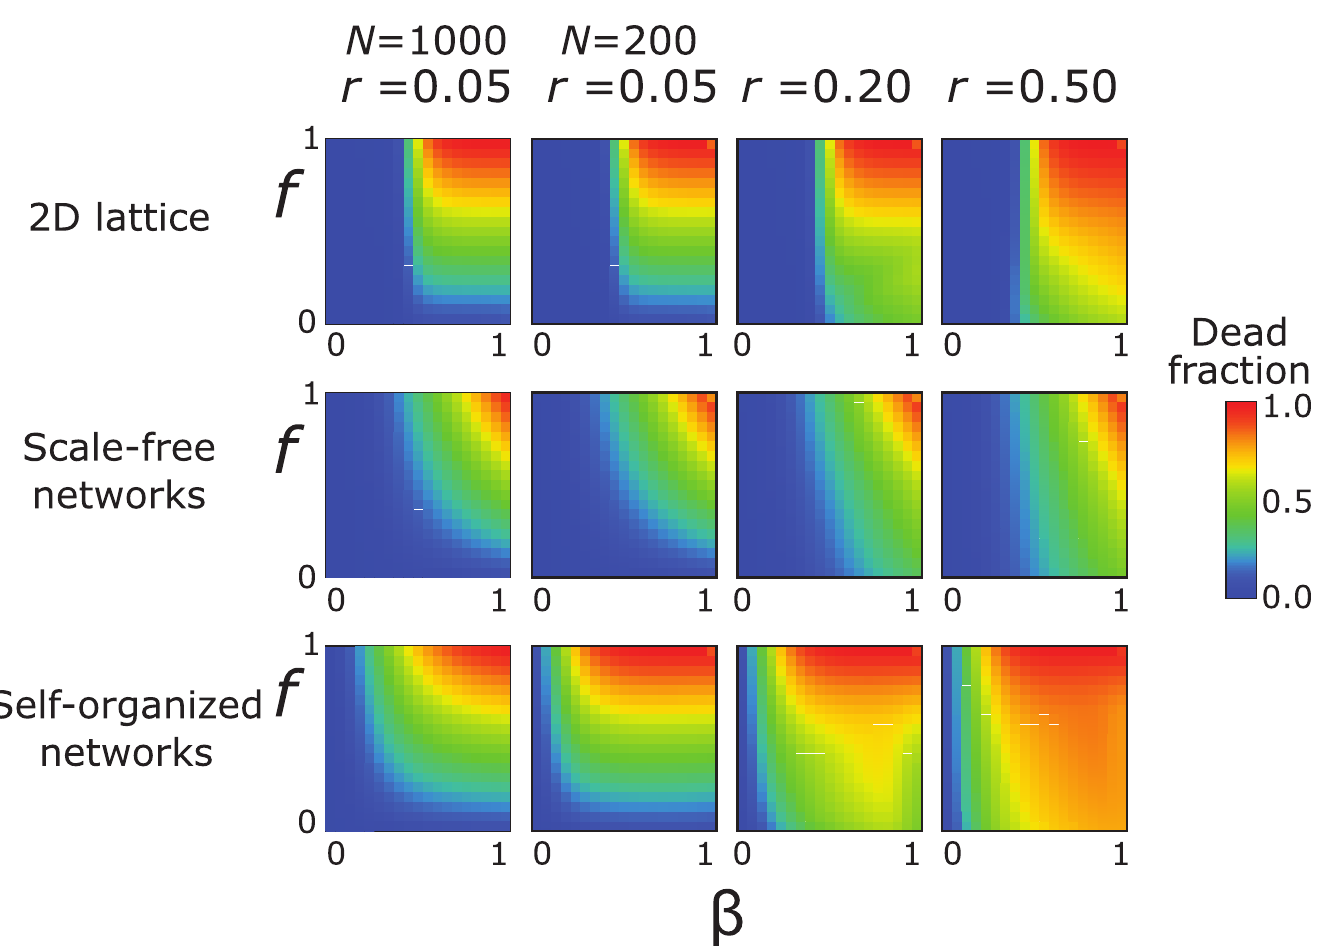
Fig 2. Fraction of the population that died because of the disease, as a function of the infection probability and the death probability. From top to bottom: two-dimensional lattices, random scale-free networks ( λ = 2.5), and self-organized networks. The x-axis corresponds to the infection probability, β , and the y-axis to the death probability, f , of an infected node. The columns correspond to the protection loss rate, r , of a node (left to right): r = 0.05 ( N = 1000), r = 0.05 ( N = 200), r = 0.20, and r = 0.50. The threshold point for a given combination of parameters is defined as the point where the diseased fraction becomes larger than zero, independently of the infected mass. In the plots, the threshold values for each case can be found at the point where the blue area turns into